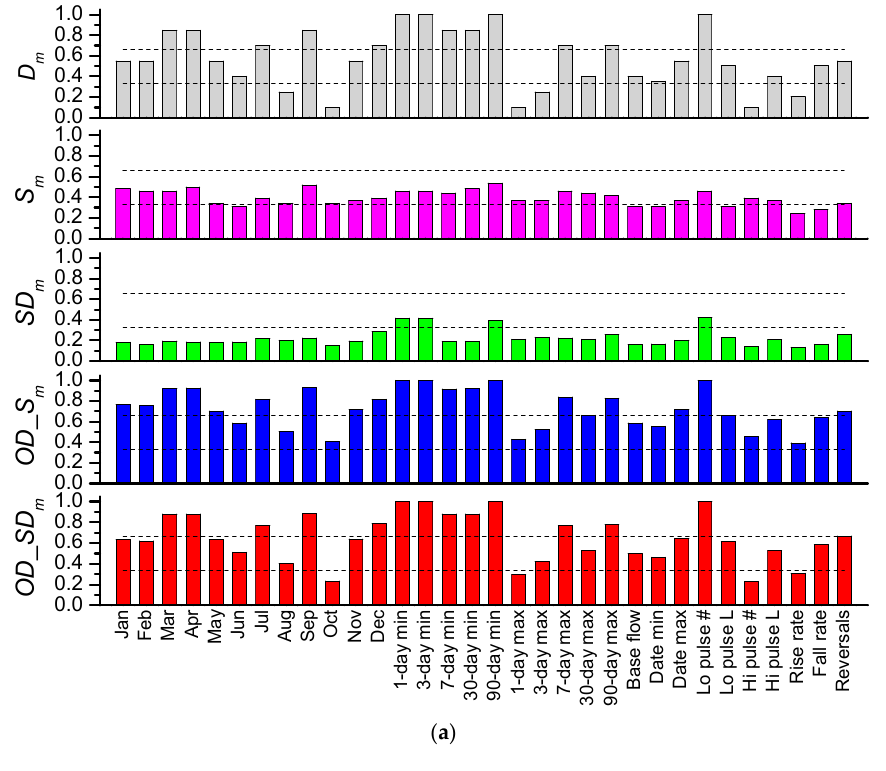
( b ) Figure 8. Alteration degree of the 32 hydrologic parameters by five assessment methods. Table 3. Alteration degree of the 32 hydrologic parameters.